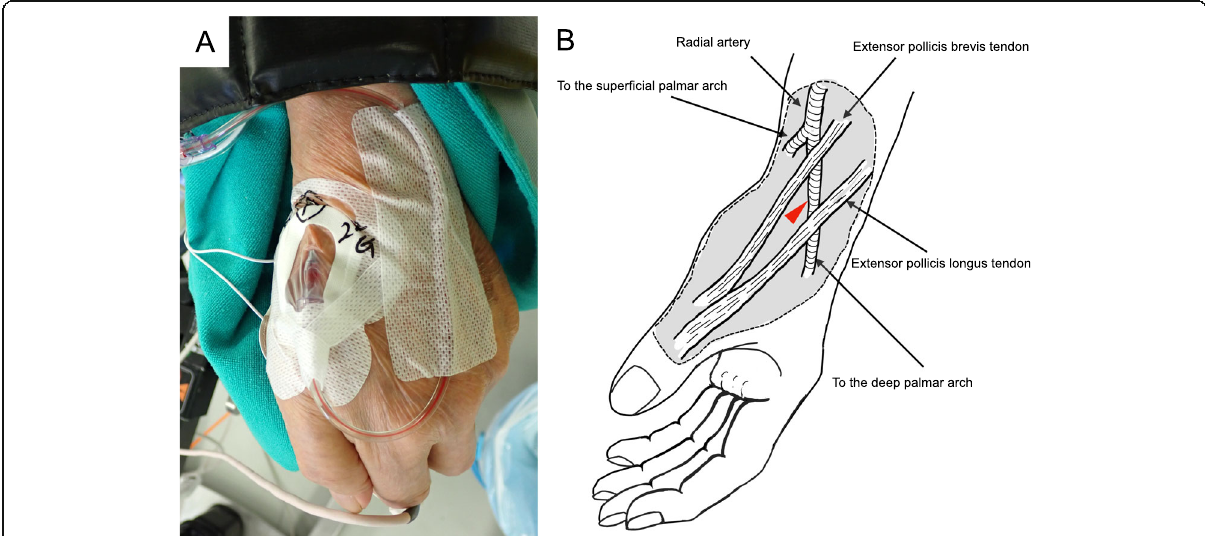
Fig. 1 a Distal radial artery cannulation in the anatomical snuffbox. An electrode for recording the motor evoked potential from the abductor pollicis brevis is attached to the thenar area. The left forearm is pronated and fixed on a padded armrest in the right lateral decubitus position. b Anatomical scheme of the entry point for cannulation of the dorsal radial artery of the left hand. The entry point is indicated by the red